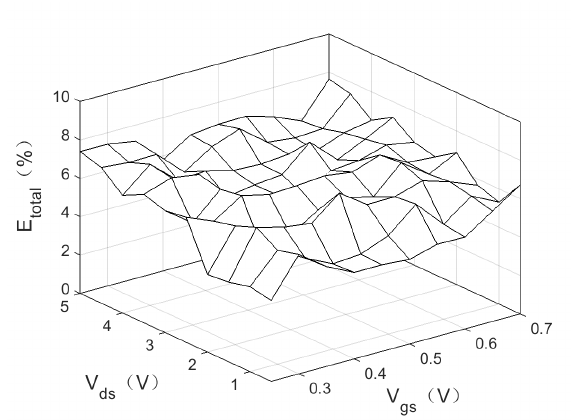
Figure 12. The total percentage error E total between simulated and measured models.